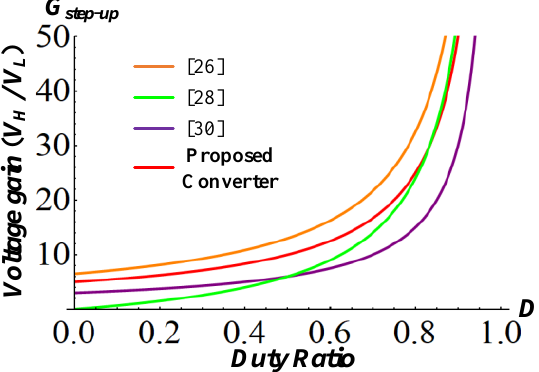
Figure 19. Comparison of voltage gains in step-up mode of the proposed converter and other bidirectional converters (in [26,28,30]). Table 2. Comparison of the proposed bidirectional converter with other studies.